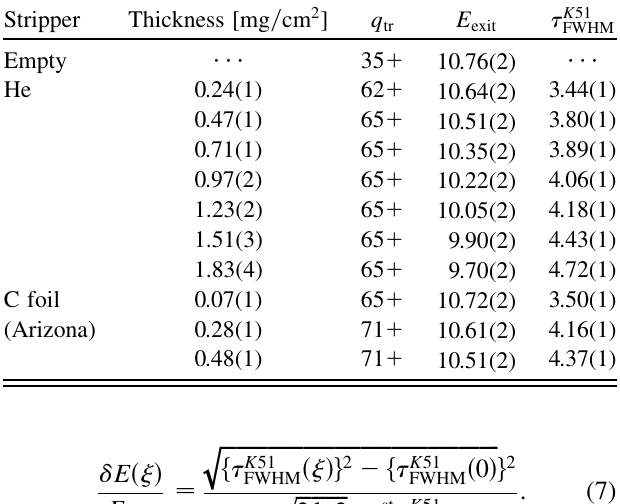
CHARGE STRIPPING OF 238 U ION BEAM BY . . TABLE II. Exit energy E after the strippers and longitudinal exit for He gas measured with plastic scintillators beam width (cid:9) K 51 FWHM (SC-H12 and SC-H16 for the energy and SC-K51 for the longitudinal profile). For comparison, the values measured with Arizona carbon-foil strippers are also listed. The charge indicates the selected and transported charge state in the state q tr measurements.